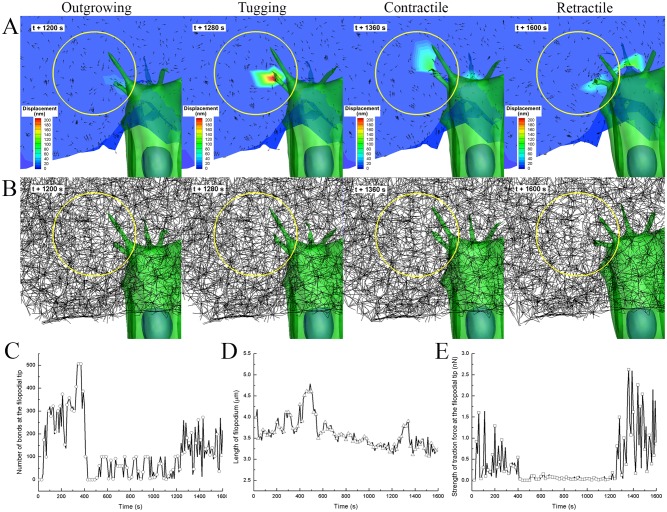
Traction simulation of ECM fiber network model with pore size of 1.5 μm.Selected examples of A) sectional contours and vector plots of ECM fiber displacement, and B) clipped view of ECM fibers network at different time points of 1200, 1280, 1360, and 1600 seconds, respectively. Temporal variations of C) number of receptor-ligand bonds at the filopodial tip, D) filopodial length, and E) the magnitude of traction force at the filopodial tip which is mechanically interact with ECM fibers.